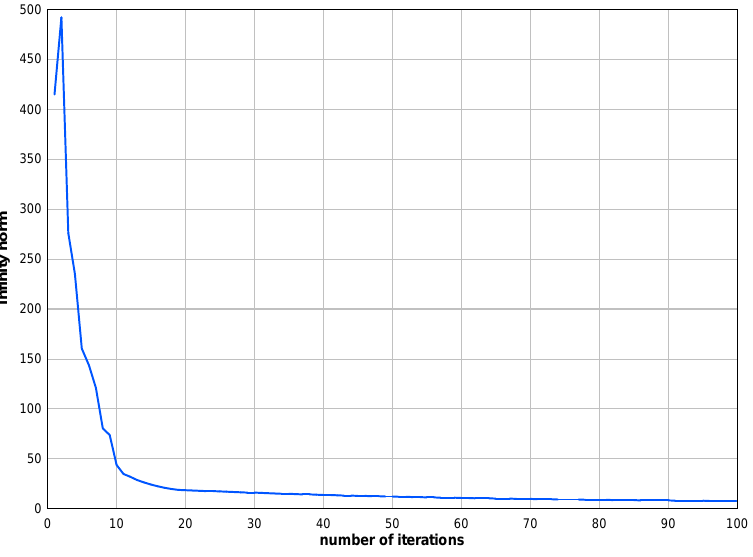
Figure 4. Convergence of the